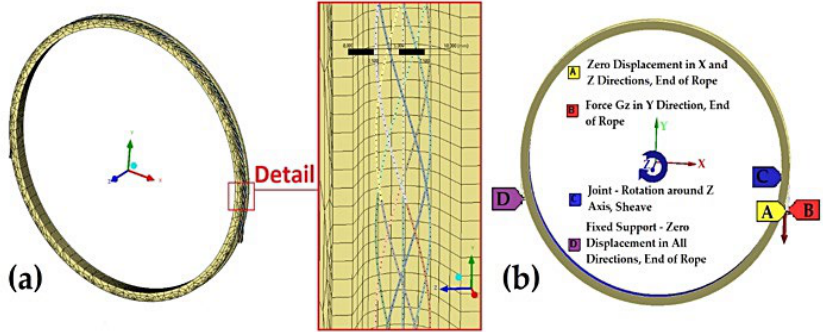
Figure 16. ( a ) FEM network of steel rope guided in a rope sheave groove; ( b ) boundary conditions of numerical problem solution. numerical problem